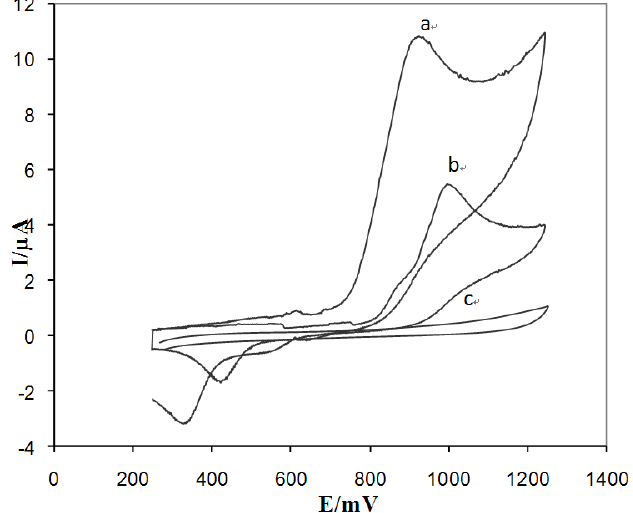
Figure 4. The voltammograms of 5.0 × 10 − 7 M diclofenac on the modified (a) and unmodified (b) carbon paste electrode at acetate buffer pH 4, (c) acetate buffer using